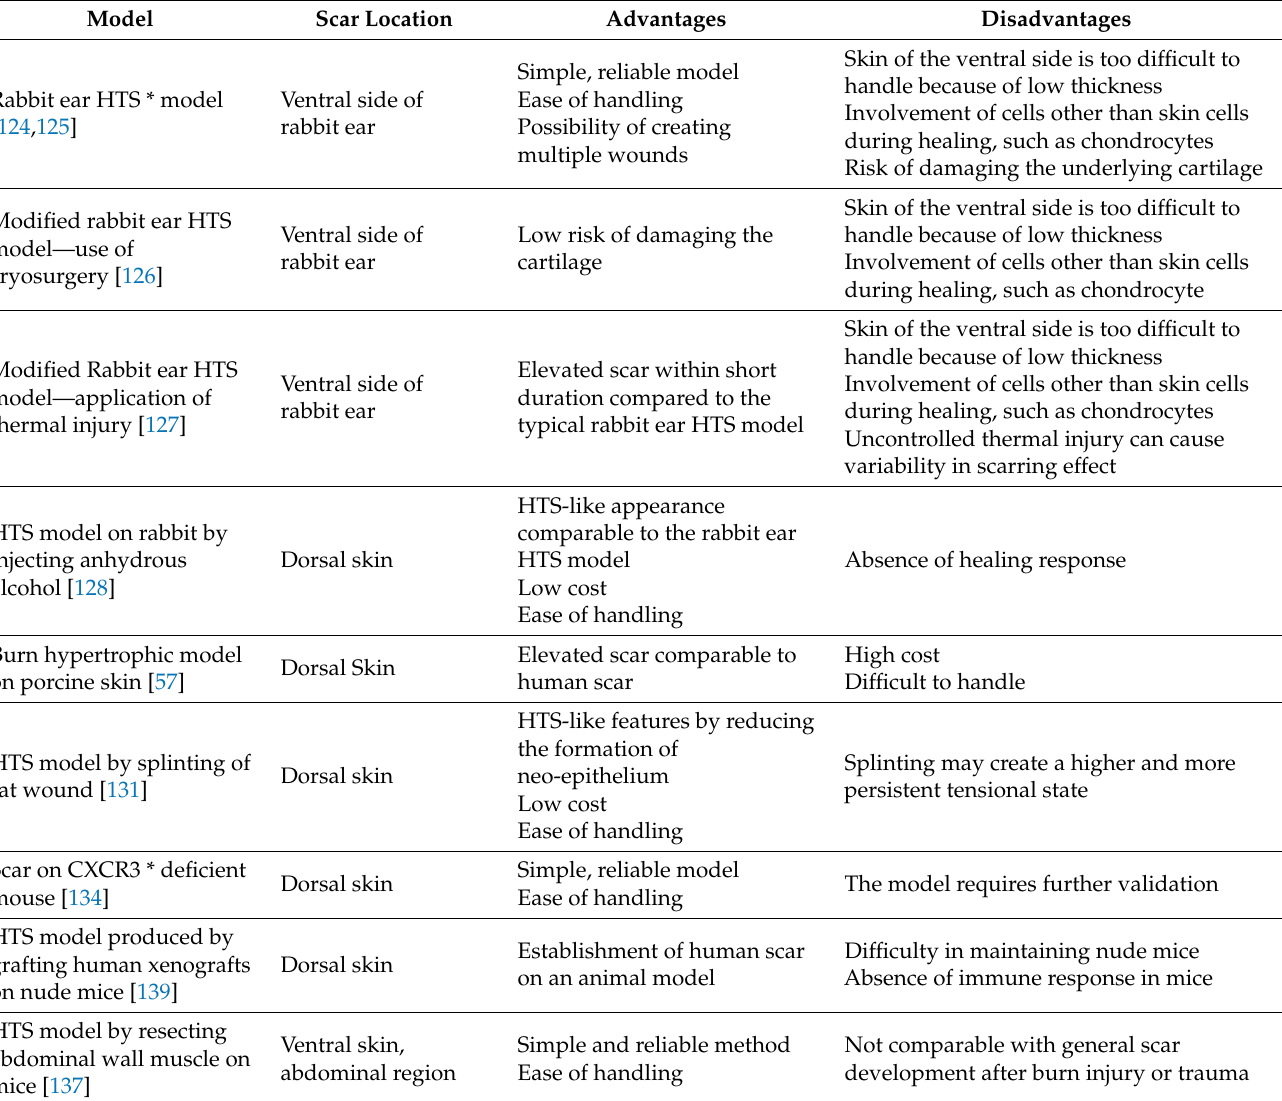
Table 1. Animal models for hypertrophic scarring